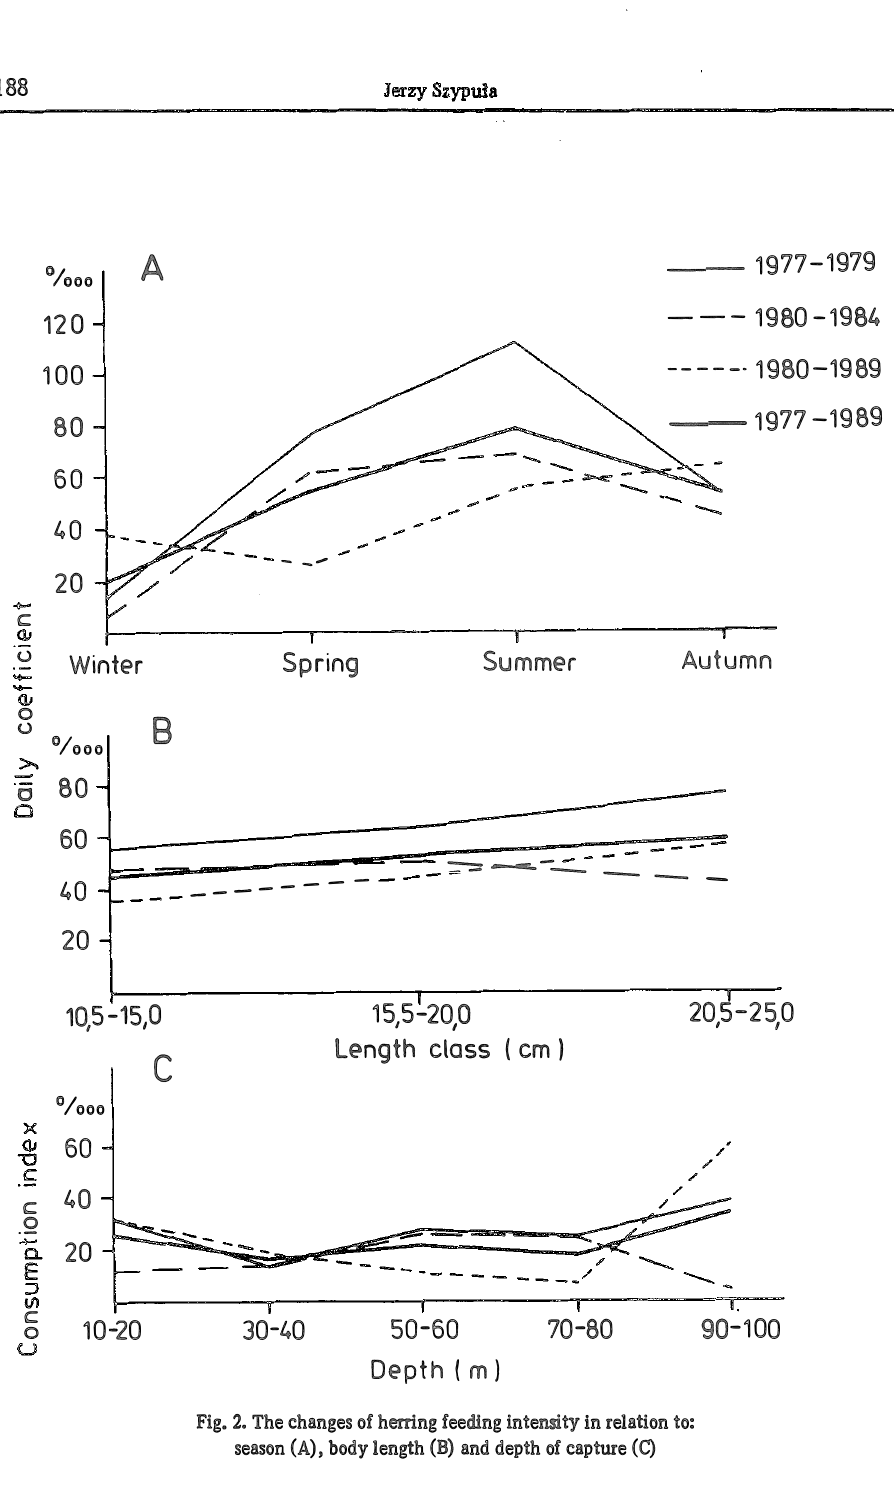
Fig. 2. The changes of herring feeding intensity in relation to: season (A), body length (B) and depth of capture (